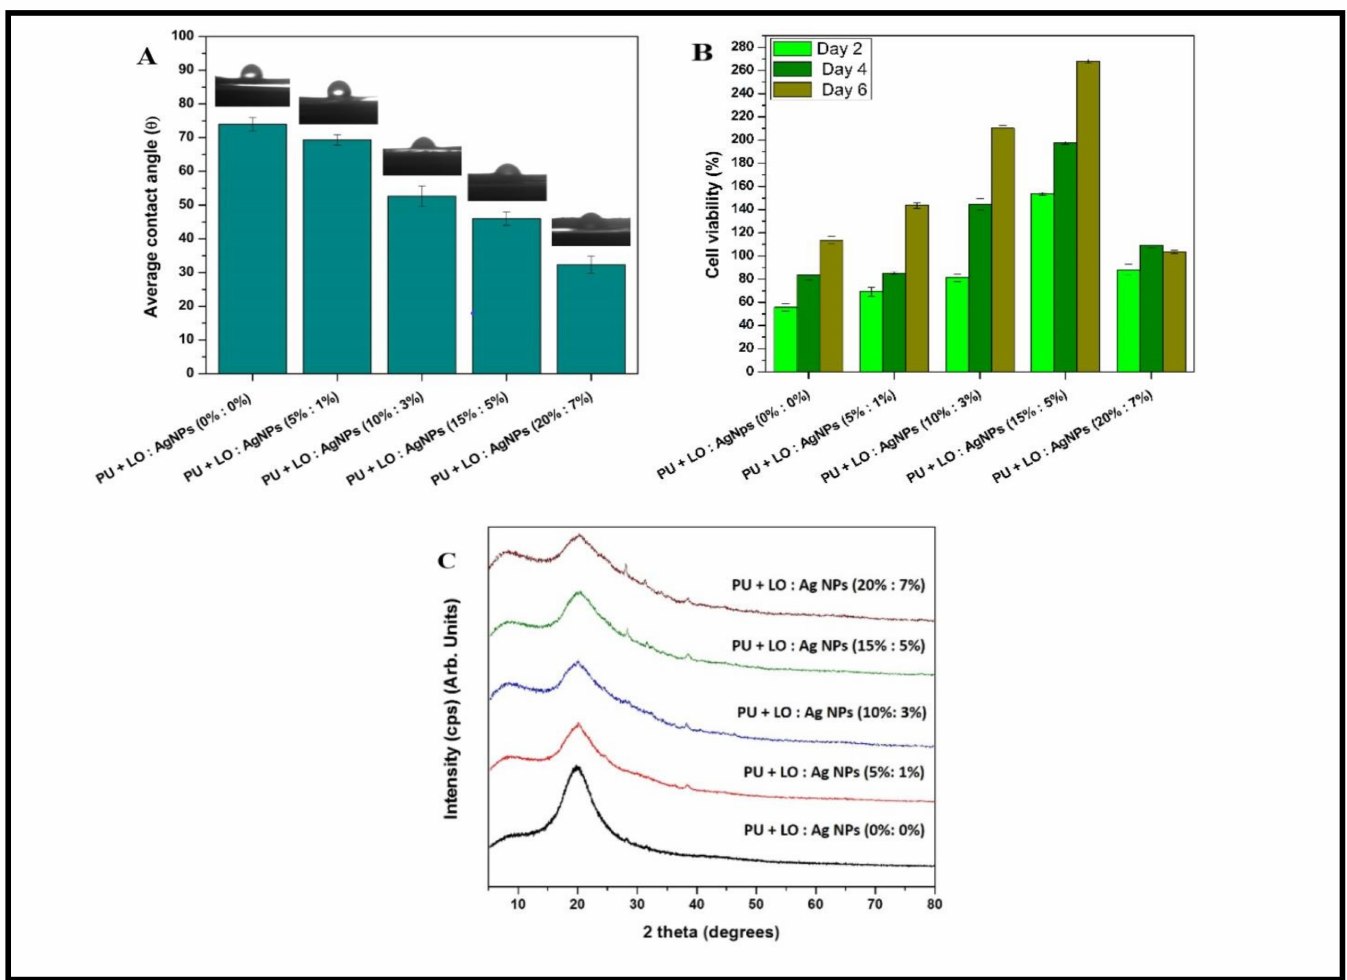
Figure 5. ( A ) The average water-contact angle of pristine nanofibers and composites containing various LO and Ag NPs. ( B ) The cell viability (%) of chicken-embryo fibroblasts cultured on days 2, 4, and 6. ( C ) XRD patterns of nanofibers and composites containing varying amounts of LO and Ag NPs. Reproduced from [107] with copyright permission from